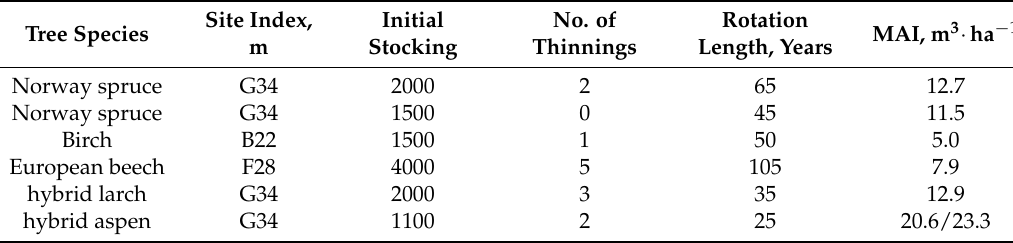
Table 1. Forest management programs and tree species used in the simulations for the representative sites in southern Sweden. Site index is the average height of the 100 largest trees per ha at a total stand age of 100 years (50 years for birch). The letter in the site index indicates the site index species (G = Norway spruce, B = Birch and F = European beech). The number in the site index shows the height (m) the stand attains at an age of 100 years (50 years for birch). Initial stocking is the stand density (stems ¨ ha ´ 1 ), MAI = Mean Annual volume